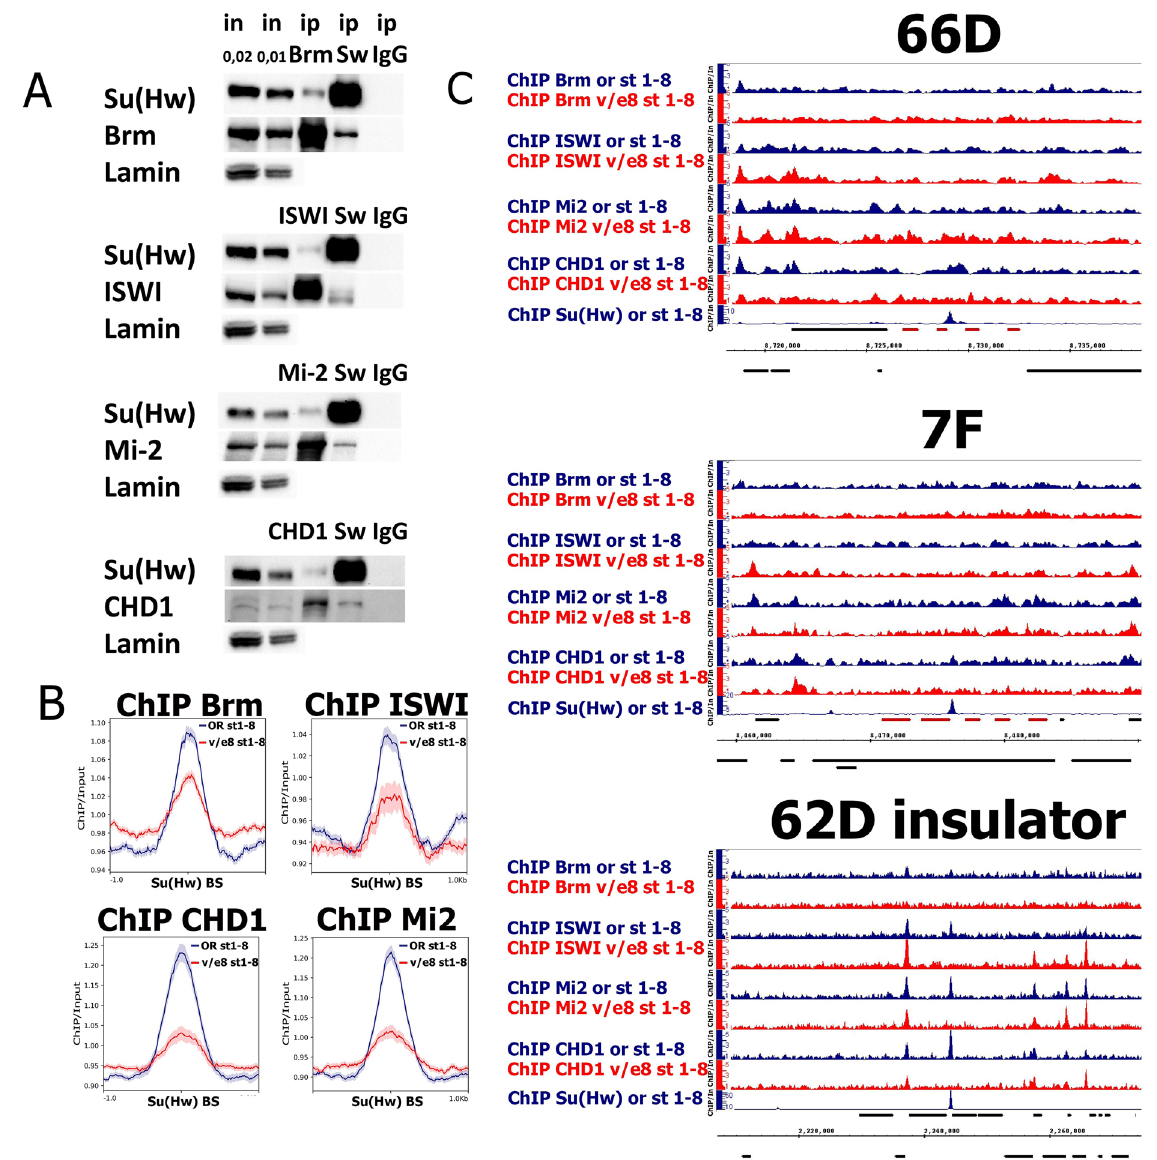
Figure 3. Su(Hw) recruits Brm, ISWI, Mi-2 and CHD-1 remodelers to SBSs but not in 66D and 7F DAFCs. ( A ) Immunoprecipitations (IPs) from nuclear protein extracts of Drosophila S2 cells. IPs were performed with antibodies against Brm, ISWI, Mi-2, CHD1 remodelers and Su(Hw) (a serum of non-immunized rabbits (ip IgG) was used as a negative control), which is indicated on the top of the figure. Western blots were stained with the corresponding antibodies indicated on the left of the figure. Anti-lamin staining was used as loading control. All input and IP samples were loaded on a single western blot. The original Western blots are present in Fig. S15. The numbers above the inputs represent a portion of a loaded fraction (in respect to the amount used for immunoprecipitations). ( B ) Average distribution of Brm, ISWI, Mi-2 and CHD1 remodelers binding on Su(Hw)-bound sites in the wild-type (or, blue profiles) and su(Hw) v / E8 (v/e8, red profiles) ovaries. The list of Su(Hw)-bound sites was calculated basing on our Su(Hw) ChIP-Seq data for the wild-type ovaries of stages 1–8. Brm, ISWI, Mi-2 and CHD1 binding levels were calculated as an enrichment (ratio of corresponding ChIP-Seq signal over input DNA). Average profiles were calculated as a median of Brm, ISWI, Mi-2 and CHD1 binding levels. The standard error is displayed on the graphs as lighter area around the main line of the profiles. ( C ) The binding profiles of Brm, ISWI, Mi-2 and CHD1 remodelers on 66D and 7F DAFCs and on 62D insulator in the wild-type (or, blue plots) and su(Hw) v / E8 (v/e8, red plots) ovaries. Only the ovaries containing egg chambers stages 1–8 were selected for analysis. Additionally, the distributions of Su(Hw) in the wild-type (or, blue plots) ovaries is shown. Protein binding levels were estimated by ChIP-Seq and represent the enrichment of ChIP-Seq signal over input. The coordinates of the X-axis correspond to the dm6 version of the Drosophila genome. The coordinates of the Y-axis represent the ChIP/Input ratio. The main chorionic genes of the loci are marked in